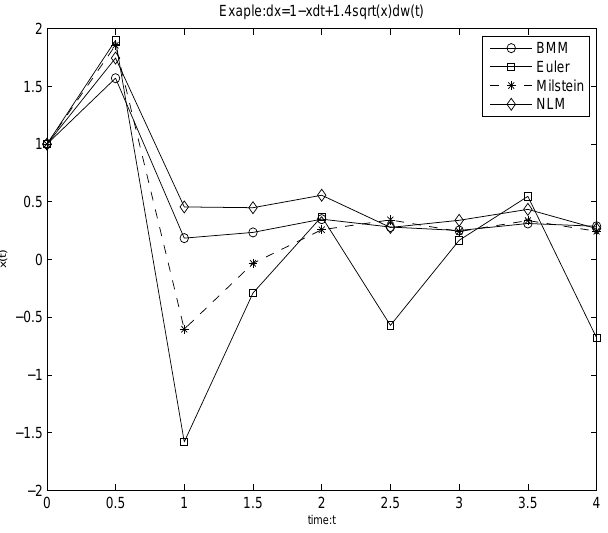
√ xdW , the time interval: [0,4],